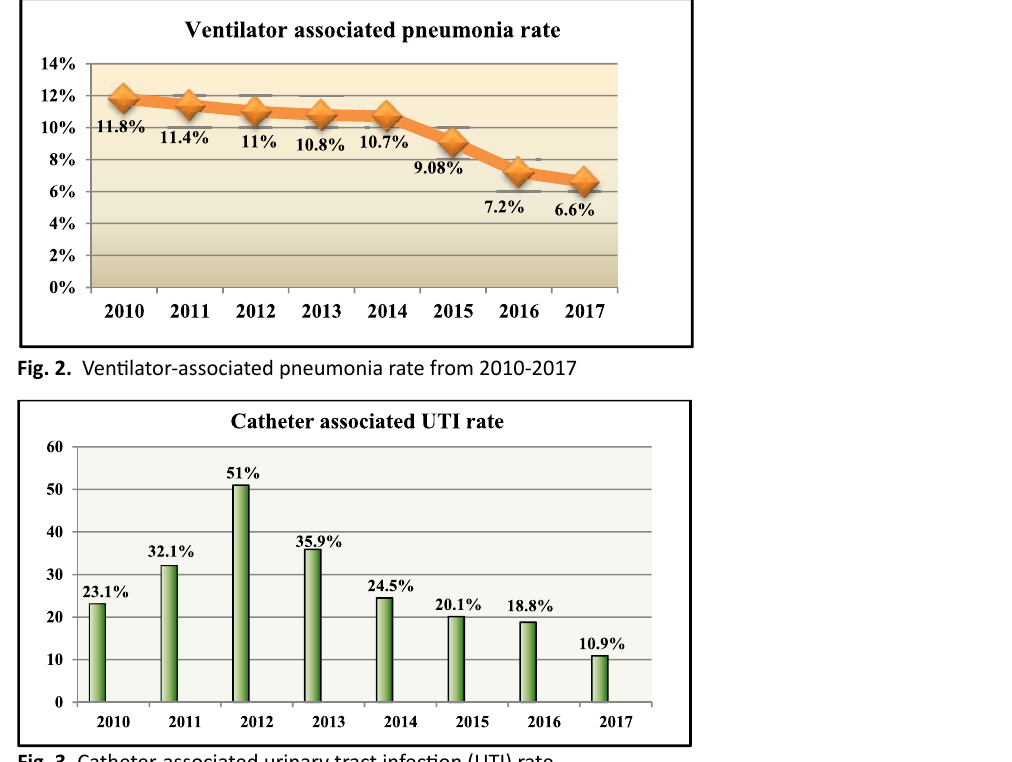
Fig. 3. Catheter-associated urinary tract infection (UTI)